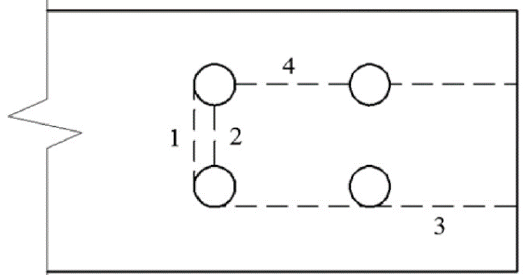
Figure 3. Failure planes during the block shear failure; 1—gross tensile plane A gt ; 2—net tensile plane A nt ; 3—gross shear plane A gv ; 4—net shear plane A nv